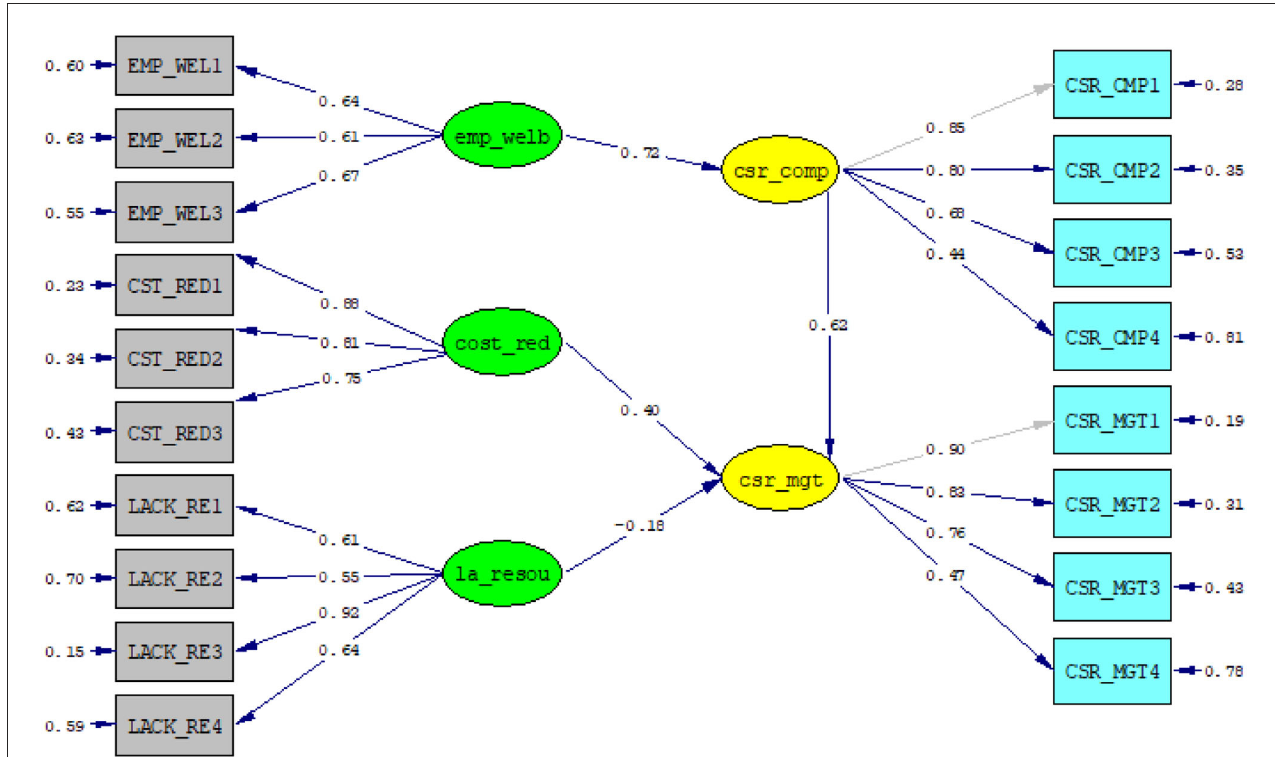
FIGURE3 Structural model.